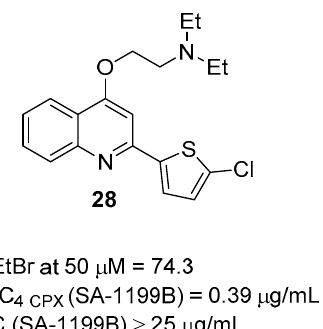
Figure 10. SAR of quinoline derivatives as NorA EPIs.